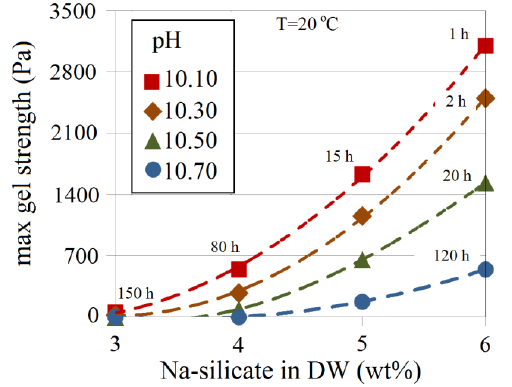
Figure 17. Maximum gel strength as a function of Na-silicate content and for different pH values. t values are presented in the graph for 6 wt% Na-silicate with different pH mgs values and different Na-silicate content at a pH of 10.10.